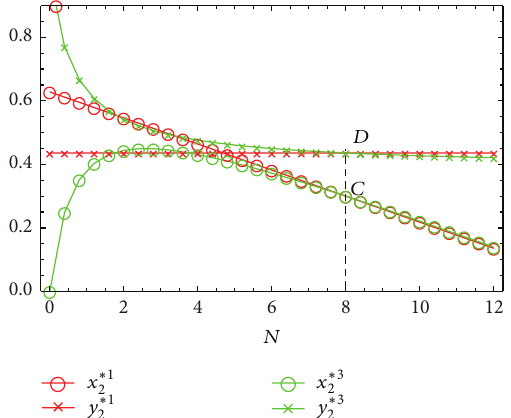
Figure 9: The changes of 𝑥 ∗ 2 and 𝑦 ∗ 2 as 𝑁 changes in compensation mechanisms 1 and 3.